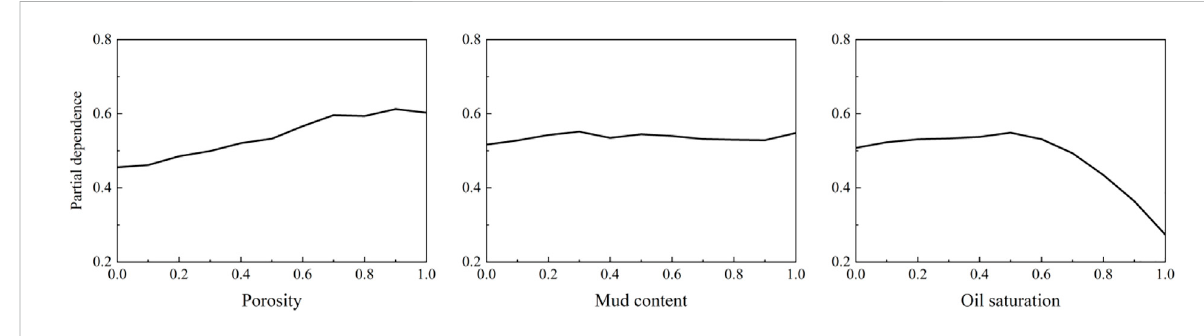
FIGURE 10 Partial dependence plot of geological parameters of GEP